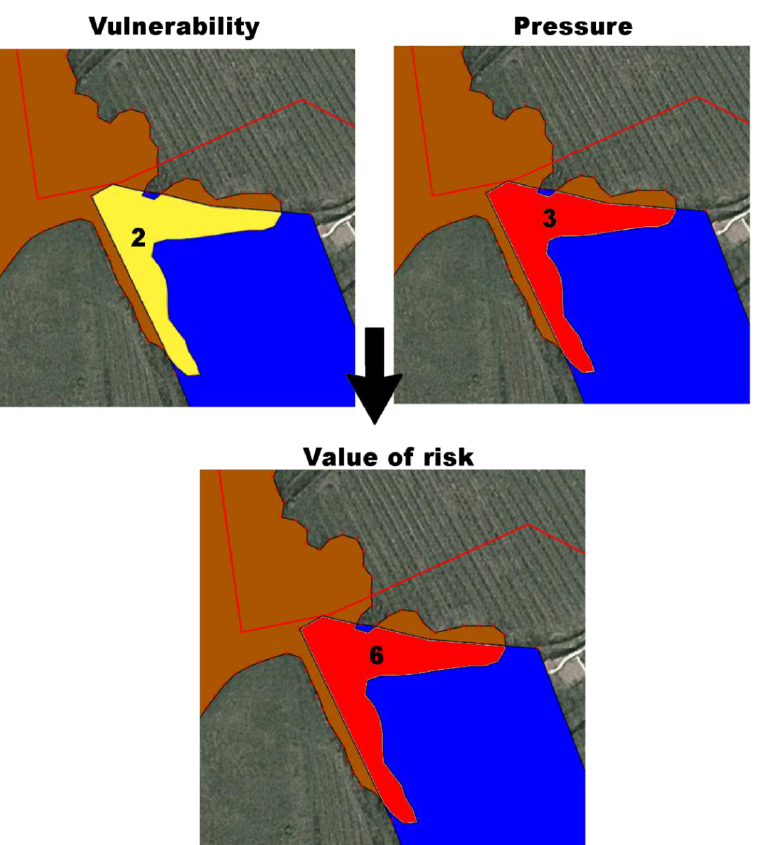
Figure 16. Risk map calculated using the risk matrix.